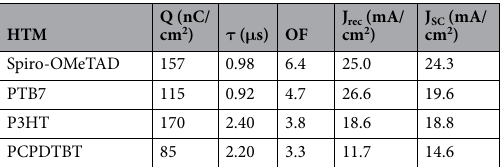
Table 3. Summary of charge density, carrier lifetime, and recombination current for each HTM based PSC. Specifically, Q is calculated with the PIDC method, τ is measured with PI-TPV at 1 sun background LI, J rec is calculated from Eq. 4 and J SC is the experimental value obtained from J-V graphs in reverse